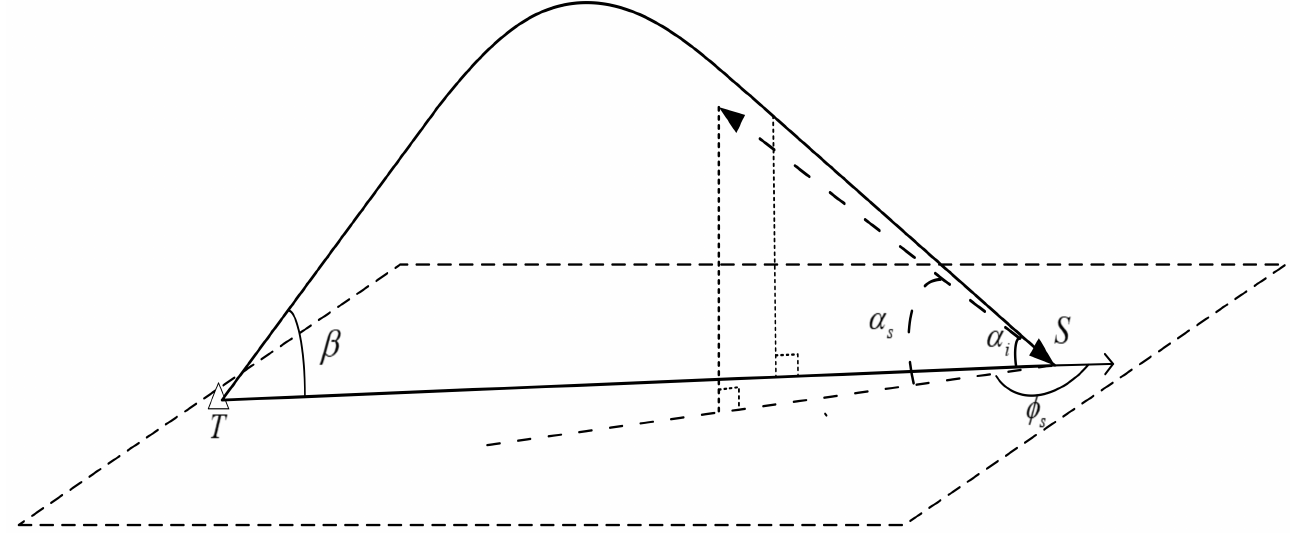
Figure 1. Schematic diagram of SWR detection: The black straight line with an arrow between T and S is the azimuth of the radar beam, which is generally considered to be 0 ◦ . The scattering azimuth corresponding to backscattering is 180 ◦